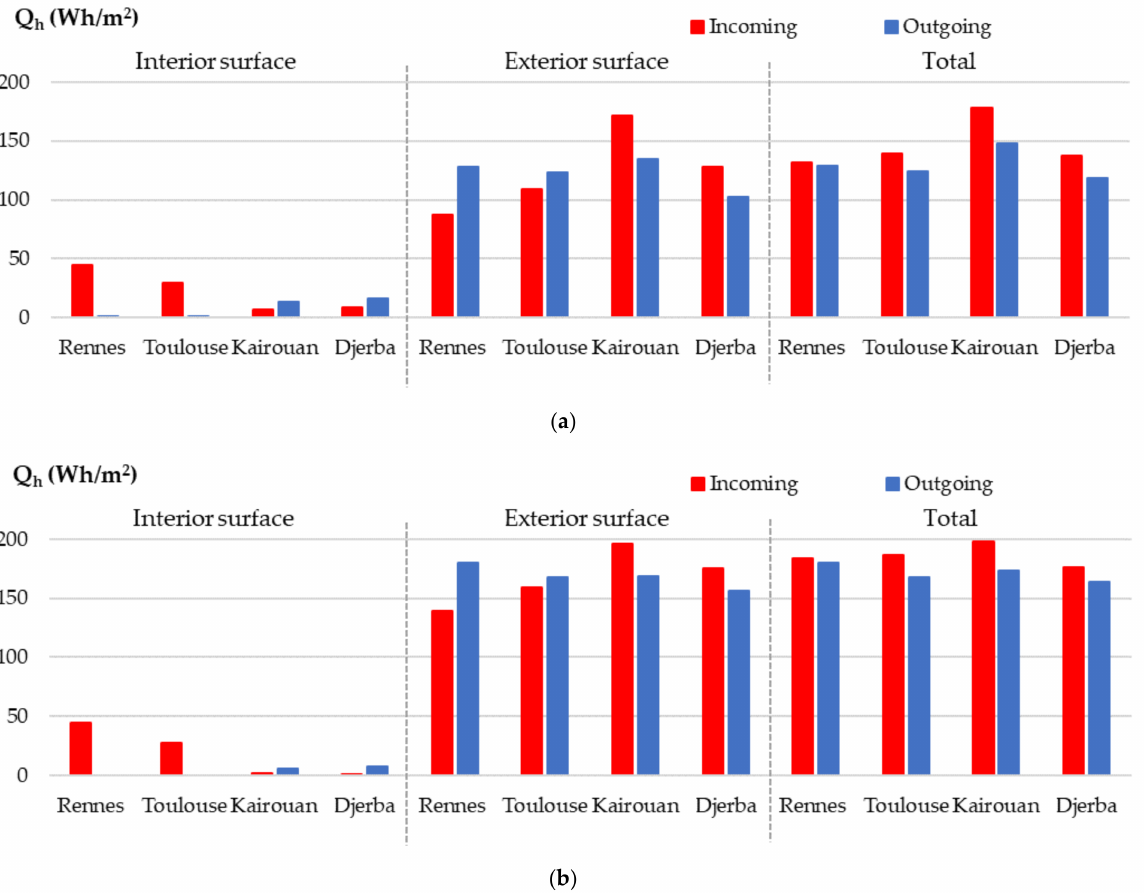
Figure 22. Incoming and outgoing heat during the last cycle on each surface of the wall and total of both surfaces. ( a ) Experimental results on heat; ( b ) numerical results on